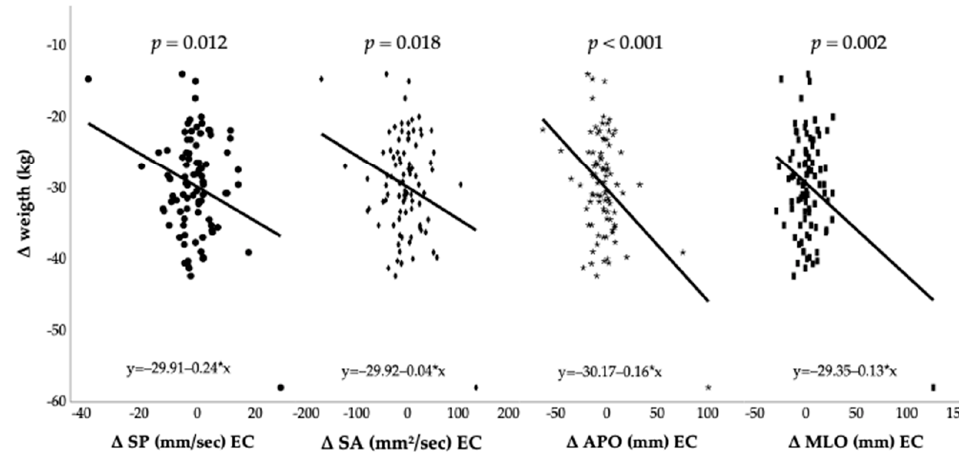
Figure 2. Post-surgery weight loss and postural control changes. Abbreviations: ∆ : difference between post- and pre-surgery outcome; SP: sway path; SA: sway area; APO: antero-posterior oscillation; MLO: medio-lateral oscillation; EO: eyes opened; EC: eyes closed.